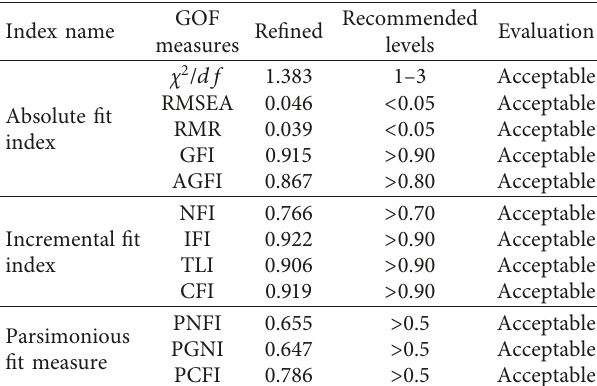
Table 6: GOF measures of the modified measurement